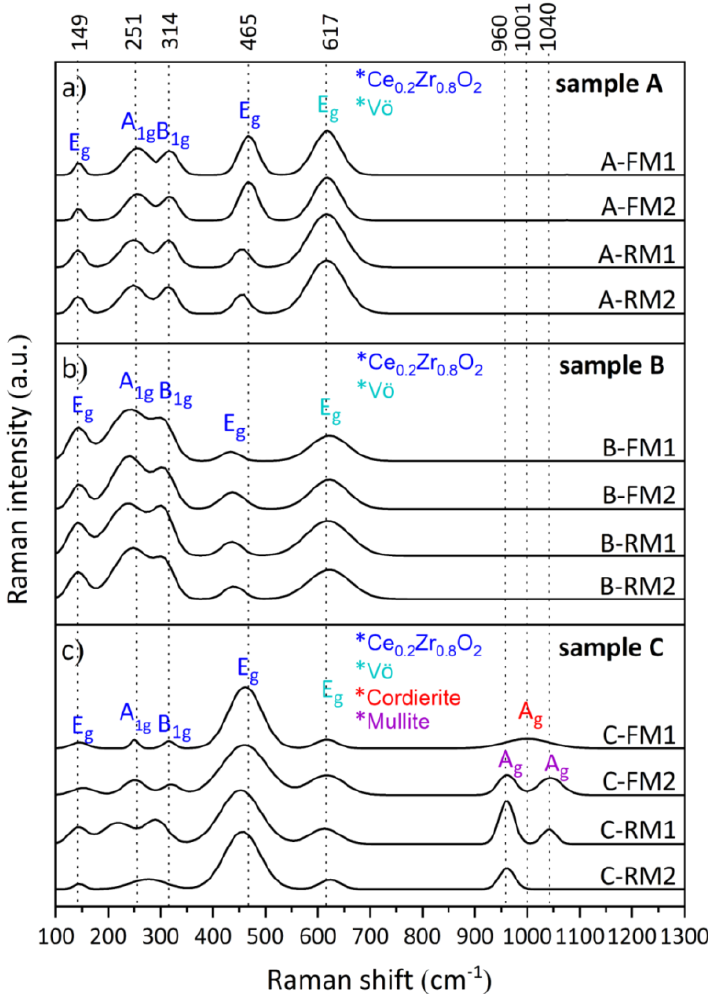
Figure 4. Identification of vibrational Raman modes associated with mineral phases in ( a ) new; used ( b ) B − TWC and ( c ) C − TWC. E g modes at 149, 456 and 617 cm − 1 correspond to oxygen stretching of Zr − O, Ce − O and Vö, respectively.